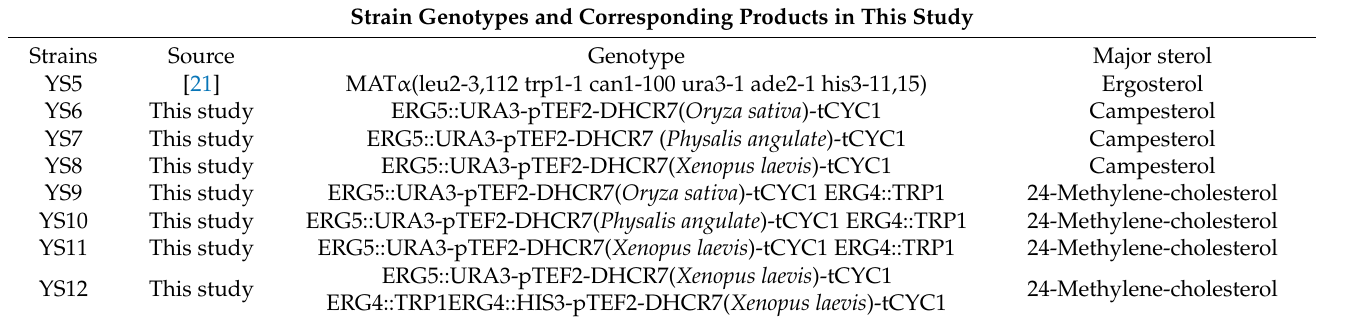
Table 1. Strains and plasmids used in this